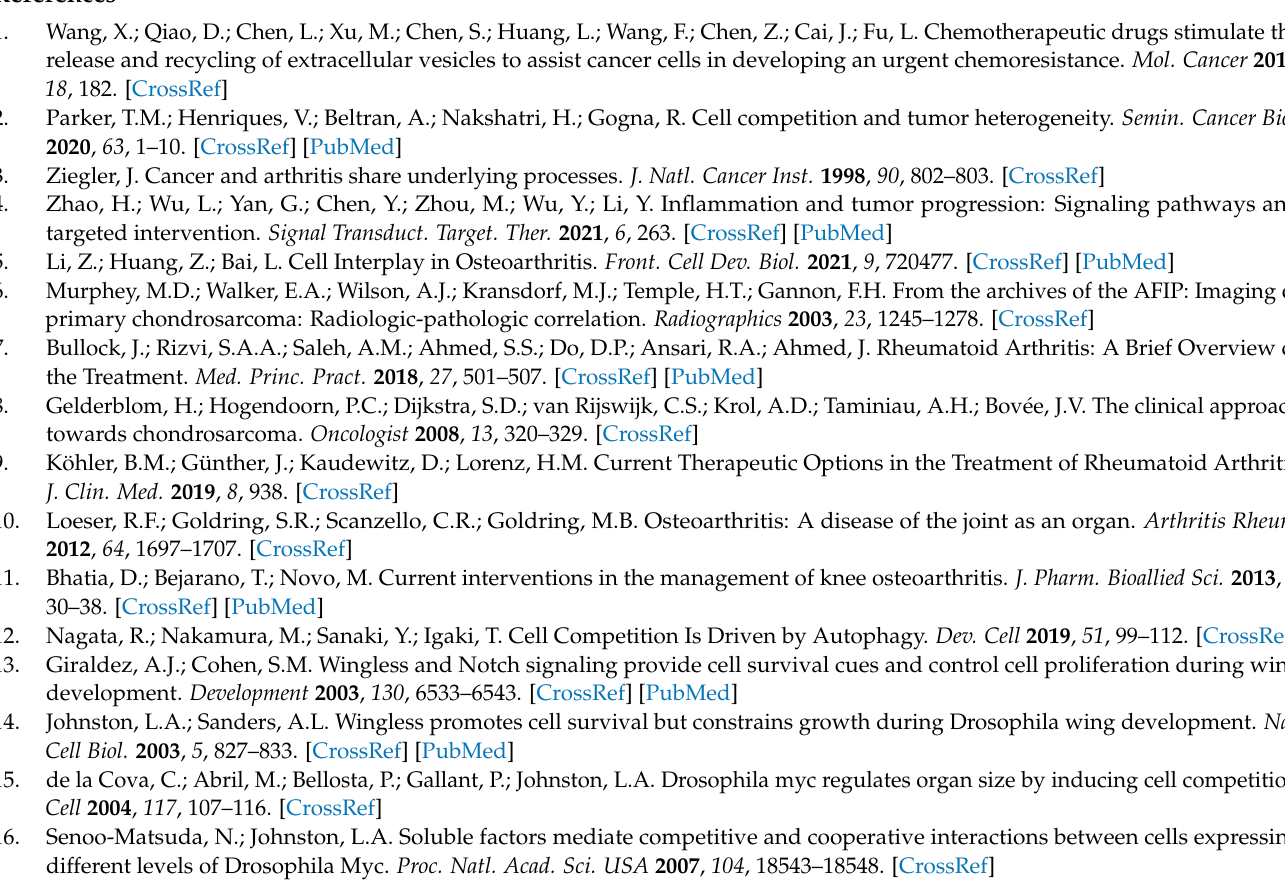
Figure S7: Downregulation of TNF α , IL1 β , and MMP13 in the synovium and the proximal bone of tumor-inoculated NSG mice in response to YS49 CM, Figure S8: Images of the uncropped Western blot gels, Table S1: List of 39 proteins that were immunoprecipitated with Hsp90ab1 in mass spectrometry- based proteomics